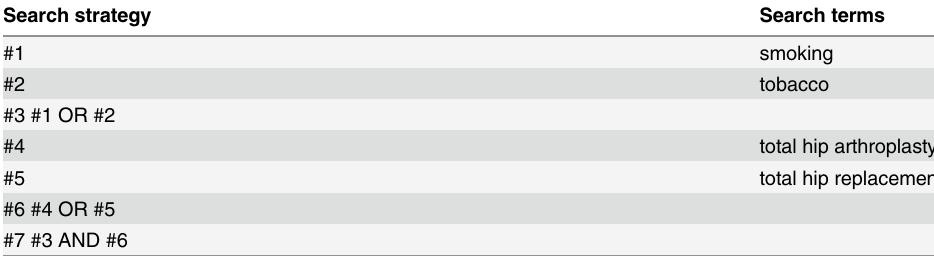
Table 1. Search strategy for PubMed on August 15,